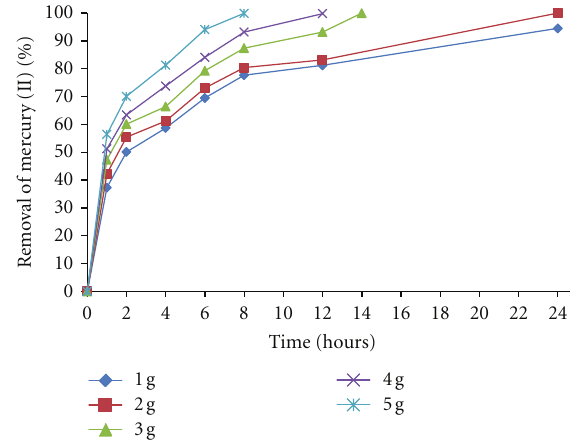
Figure 4: The e ff ect of fungal biomass concentration on the removal of mercury (II). 100mg/L, mercury (II), 100rpm, 30 ◦ C, pH 5.5.